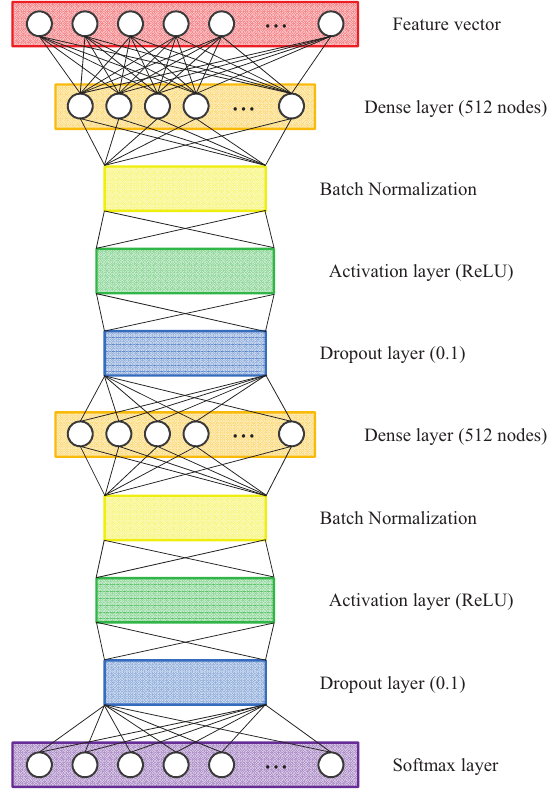
Figure 10. Architecture of deep neural network for person